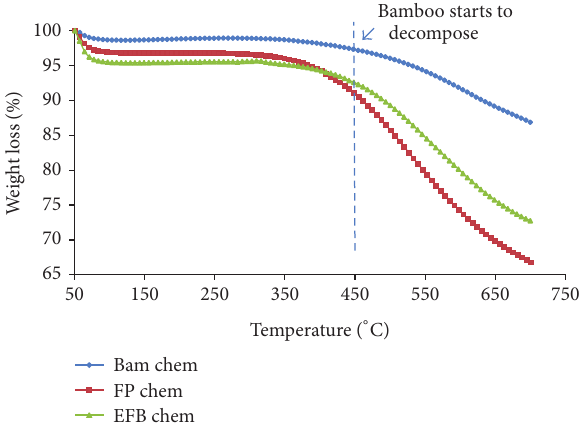
F 8: TGA analyses for bamboo, FP, and EFB carbons from dehydration